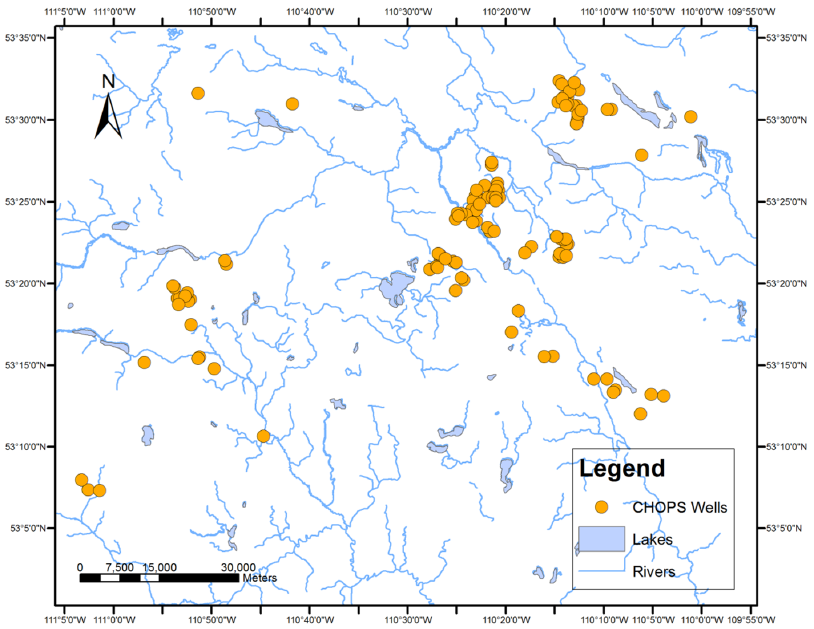
Figure 5. Geospatial distribution of the studied 118 wells in Alberta, Canada.